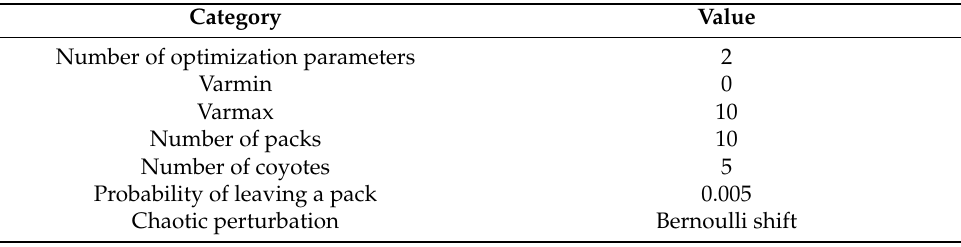
Table 6. Parameters of BCOA in optimization of KELM.